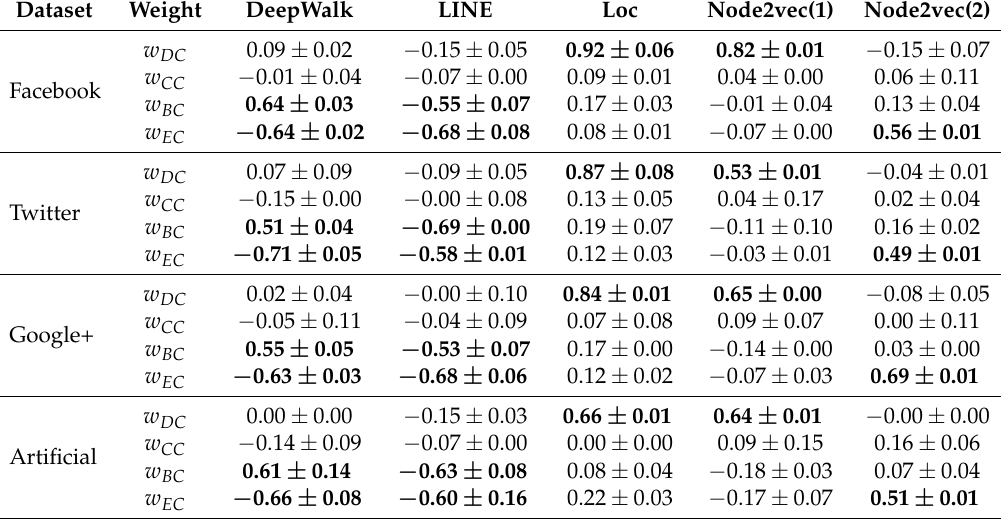
Table 3. Weights learnt by rankSVM for Degree Centrality ( w DC ), Closeness Centrality ( w CC ), Betweenness Centrality ( w BC ) and Eigenvector Centrality ( w EC